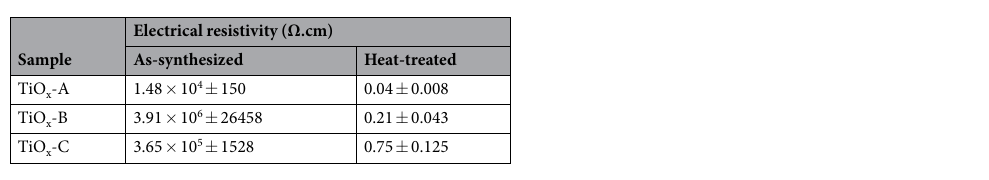
combine with titanium ions 21 . The source of the OH group is likely the water vapour in the air, which made a contact with the particles during the particles evacuation from the particle collector post-synthesis. Plasma-synthesized particles often contain neither oxides nor hydroxides, provided they are confined in the reactor 22 .